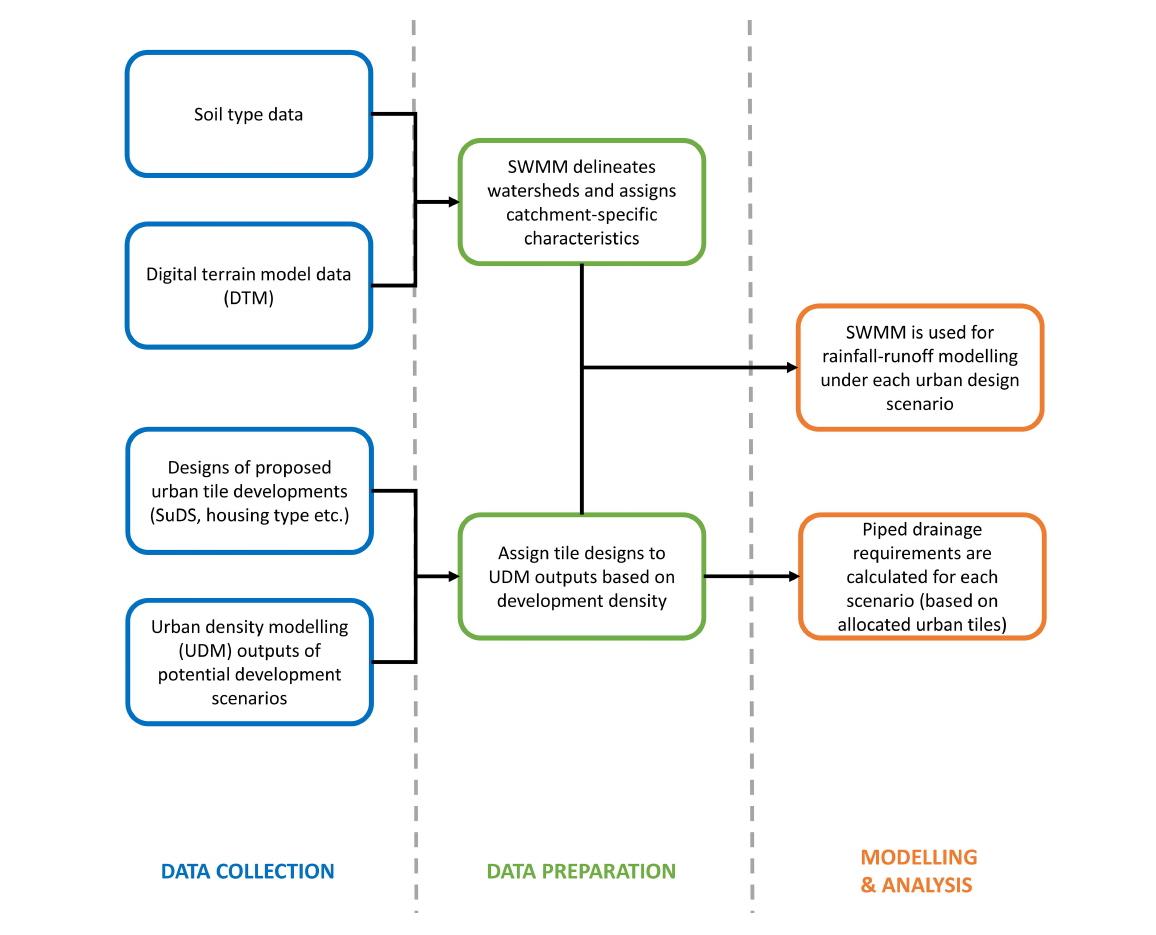
FIGURE1 Flowchart showing overall methodology